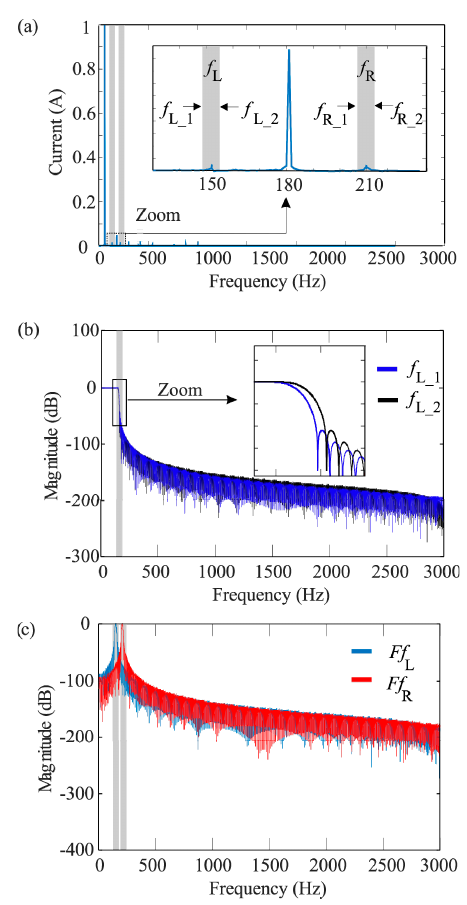
Figure 3. Filter design: ( a ) Frequencies of interest, ( b ) brick-wall low-pass filters and ( c ) brick-wall band-pass filters.